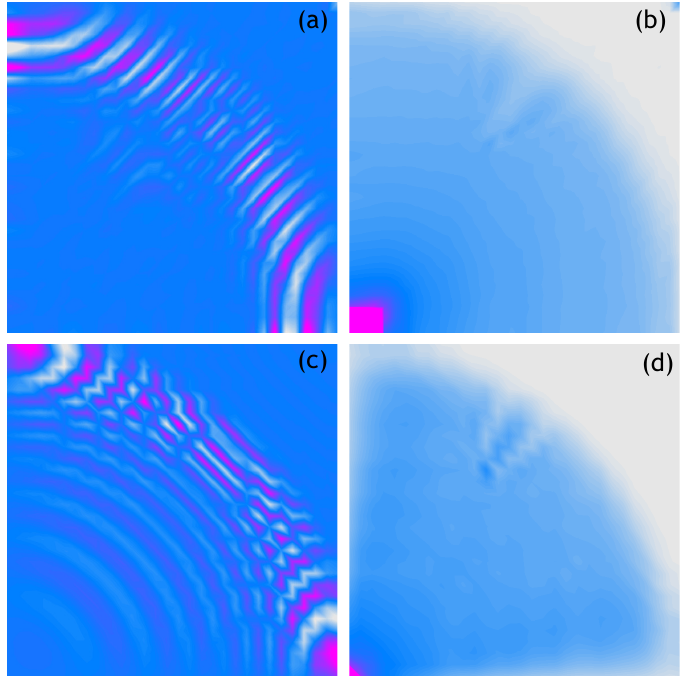
Figure 7. Wave propagation velocity patterns registered at 0.8 ms with 30 × 30 mesh grid, ( a ) Experi- mental data, ( b ) RMS of experimental data, ( c ) Calculated data, ( d ) RMS of calculated